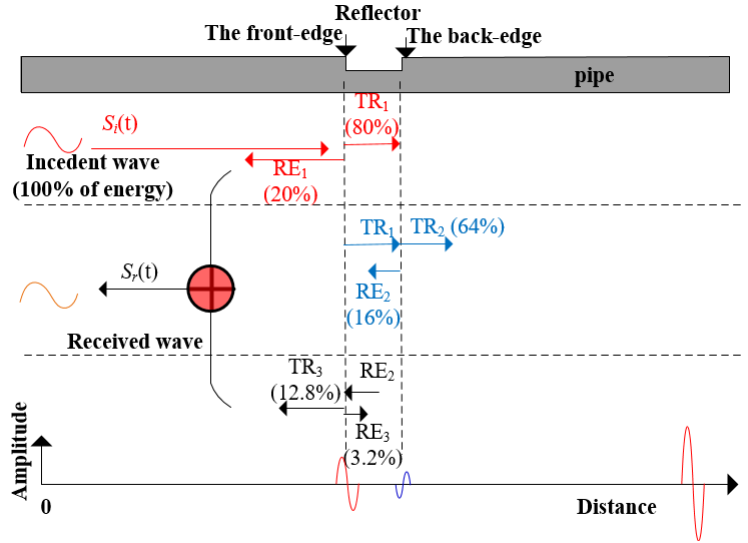
Figure 6. Wave propagation paths corresponding to the individual signals in a pipe with a reflector .